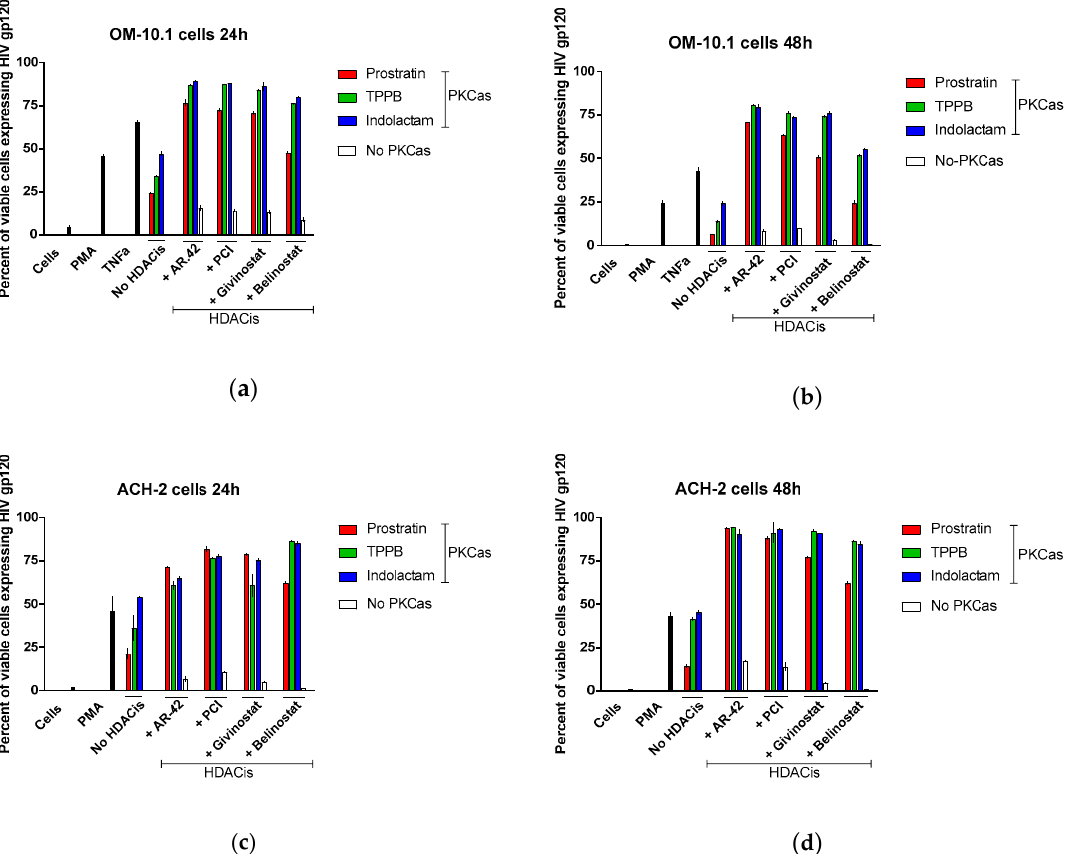
Figure 8. Combinations of LRAs induce gp120 expression in latently infected cells. OM-10.1 cells ( a , b ) and ACH-2 cells ( c , d ) were treated with LRAs alone or in combination and analyzed for gp120 expression following 24 h and 48 h treatment. OM-10.1 positive control cells were treated with PMA or TNF α . ACH-2 positive control cells were treated with PMA. Cells were incubated with anti-HIV-1 gp120 mAb VRC03, and the gp120 expression was evaluated using flow cytometry by gating on live cells. The percentage of positive cells was reported. Red columns represent cells treated with prostratin in combination with or without HDACis; green columns are cells treated with TPPB in combination with or without HDACis; blue columns are cells treated with indolactam in combination with or without HDACis; and white columns are cells treated with a single HDACi. Data are shown as mean ± S.D. of three independent experiments.